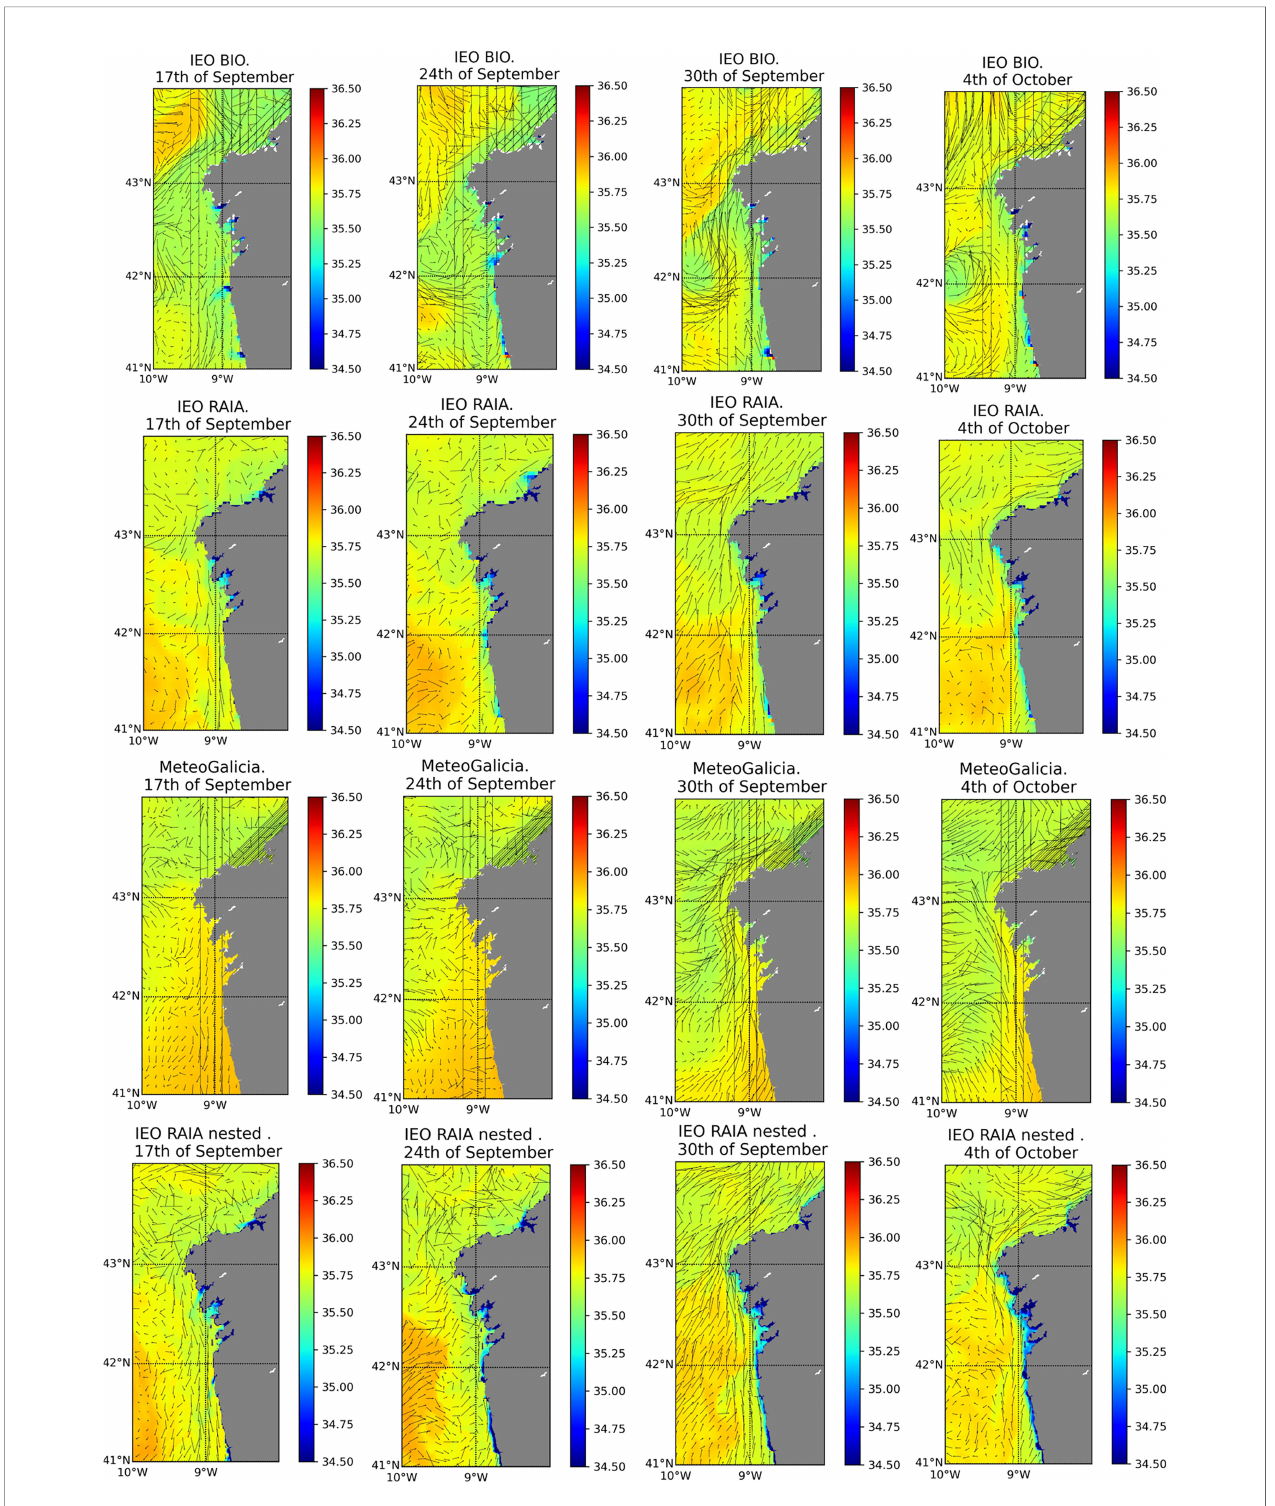
FIGURE 11 | Surface current velocities and surface salinities at relevant dates during the 2013 HAB event for the model con fi gurations: IEO BIO, IEO RAIA, MeteoGalicia and IEO RAIA